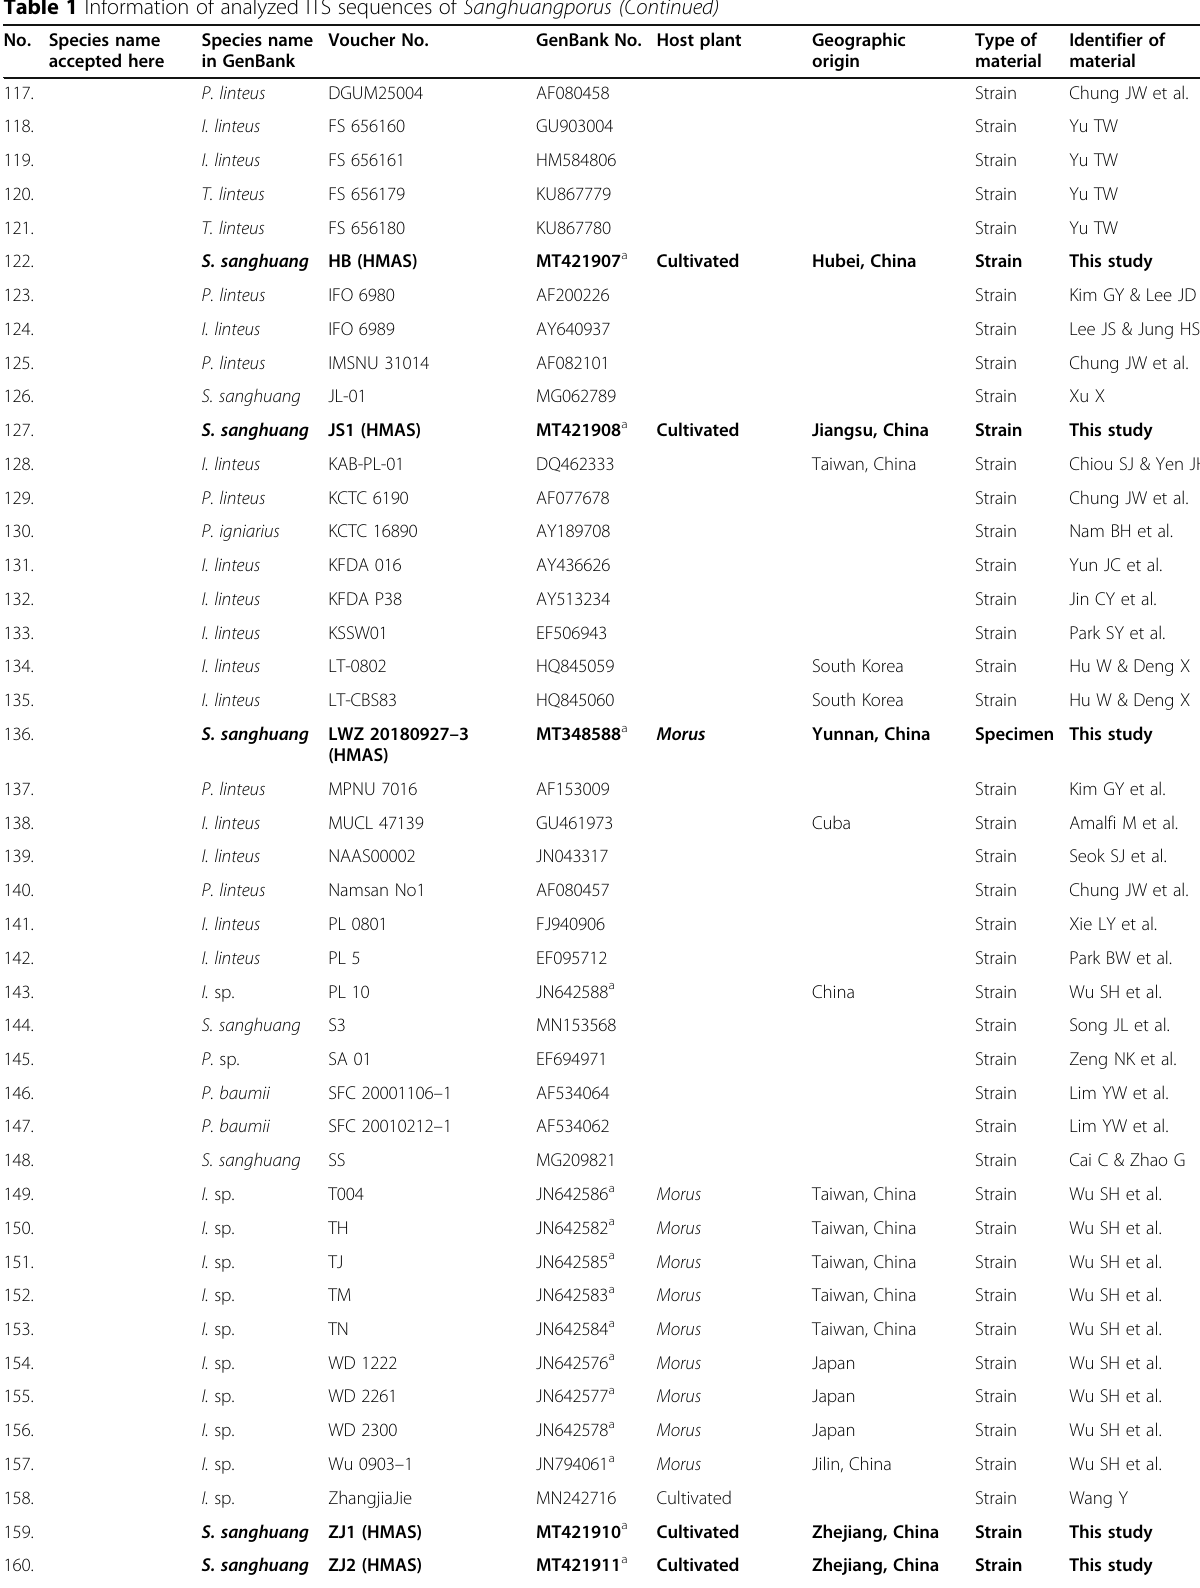
Table 1 Information of analyzed ITS sequences of Sanghuangporus